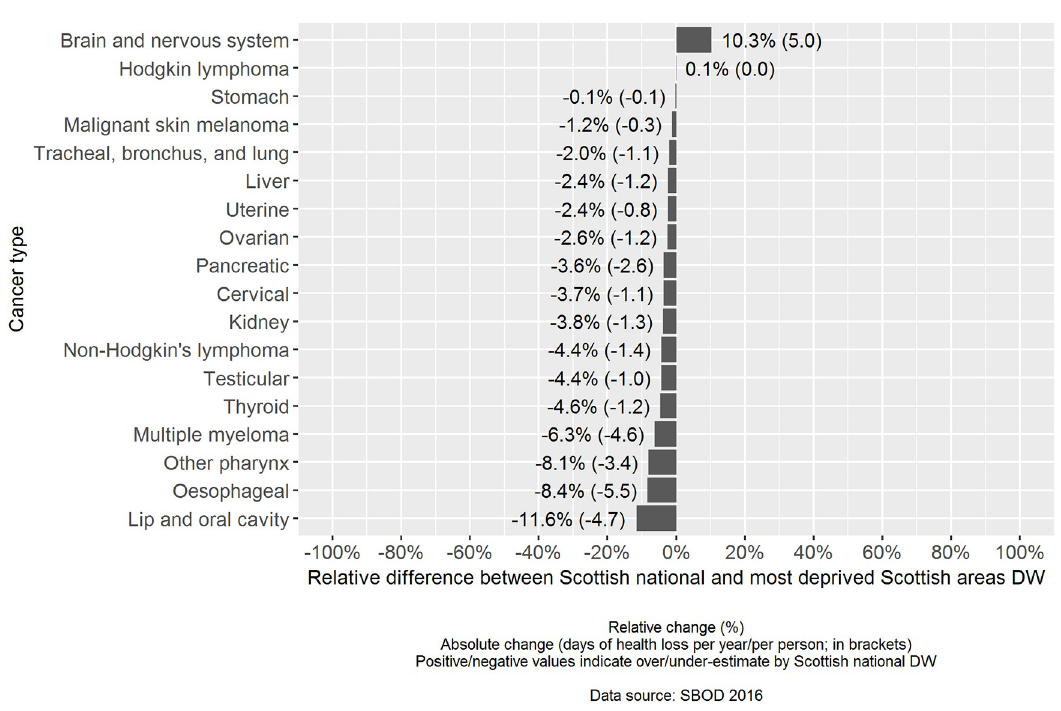
Fig 2. Relative and absolute comparison of cancer disability weights: Scottish national versus most deprived fifth of Scottish areas.